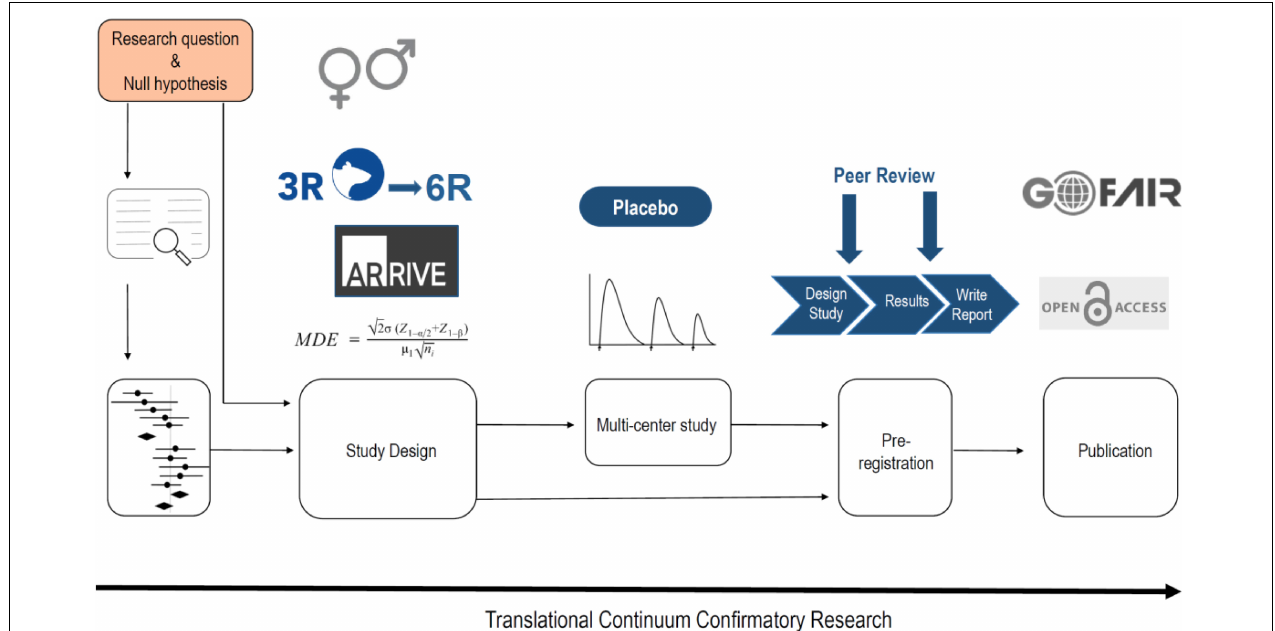
FIGURE 2 | The workflow of a confirmatory animal study. If possible the null hypothesis should be based on a systematic review and even better for a quantitative statement on a meta-analysis. However, for most hypotheses it is not possible to perform a meta-analysis. The study design should include a power calculation, should adhere to the ARRIVE 2.0 guidelines and the 3R/6R principles, and should involve both sexes for generalization. For drug testing a multi-center study provides best translation and should consider tolerance development and a correction for the placebo effect. The study has to be pre-registered also in the form of a registered report. The publication should be open access and all digital data should be handled in accordance to the FAIR